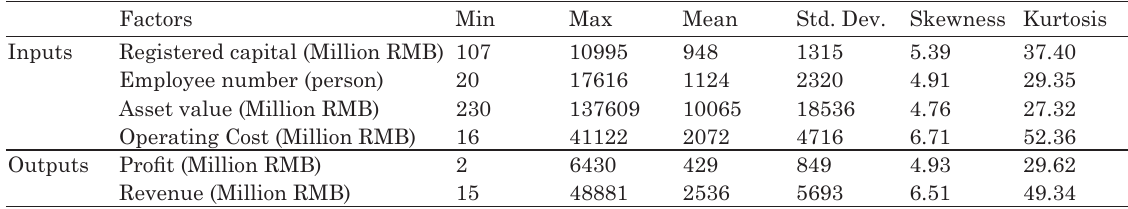
table 1. Descriptive statistics for the